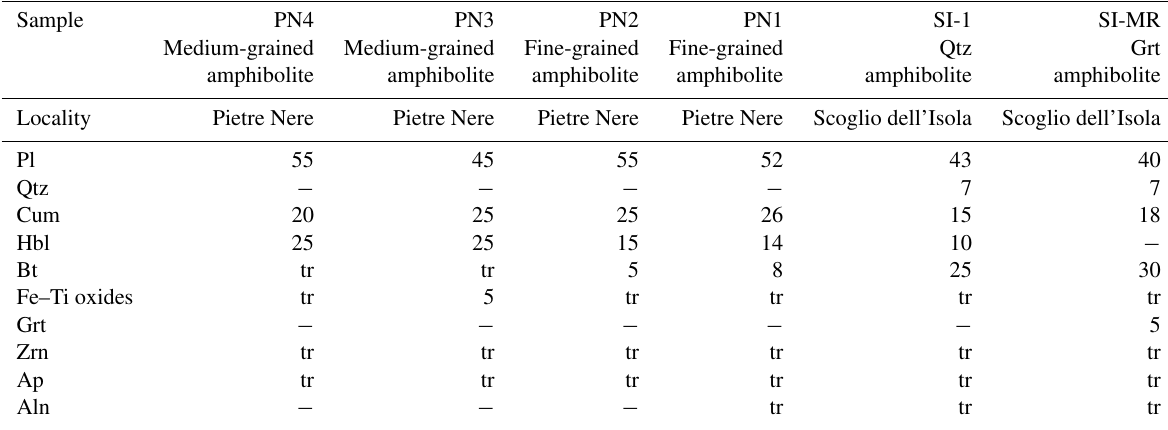
Figure 3. (a) Backscattered electron image showing the poikilitic garnet of sample SI-MR; (b) X-ray mapping image of the poikilitic garnet (hc: high concentration, lc: low concentration). Table 1. Modal composition (vol%) obtained by visual